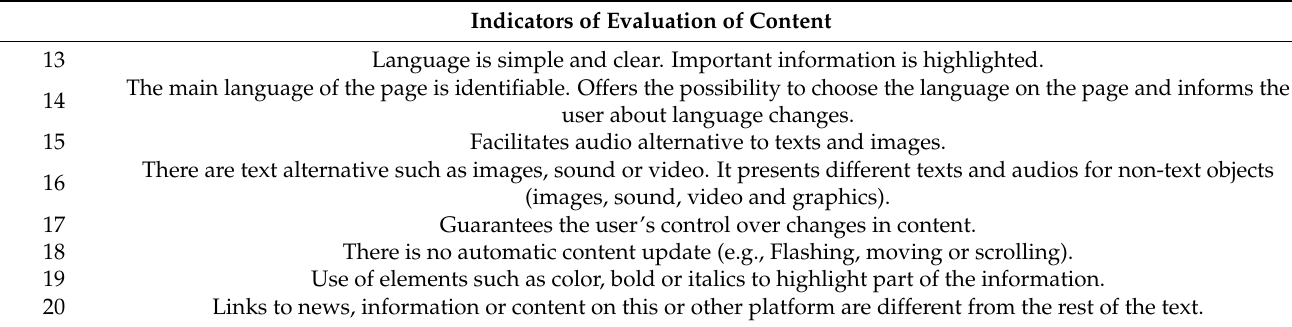
Table 2. Indicators for the analysis of the content of Portuguese apps. Indicators of Evaluation of